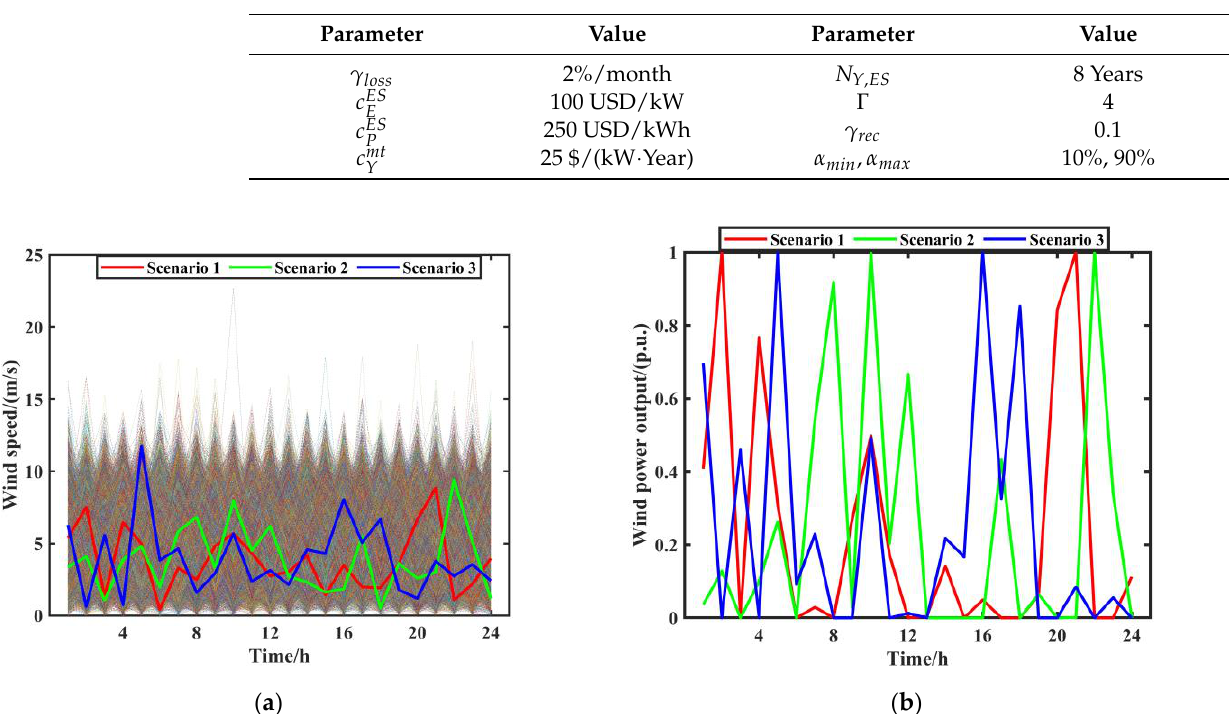
Table 3. Parameters of energy storage to be planned.